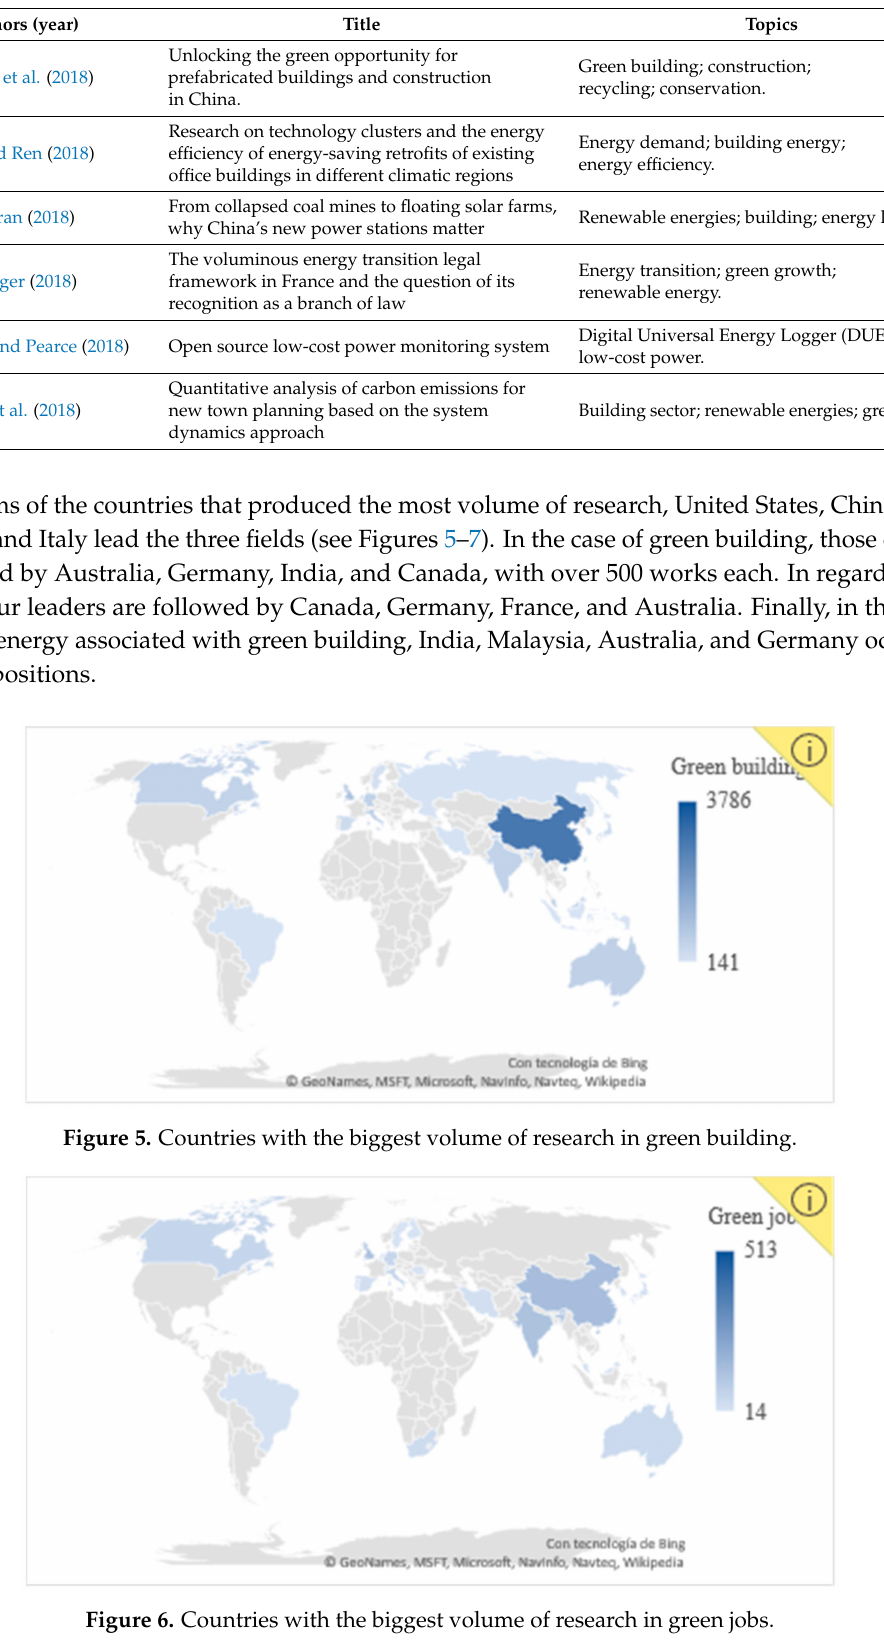
Figure 6. Countries with the biggest volume of research in green